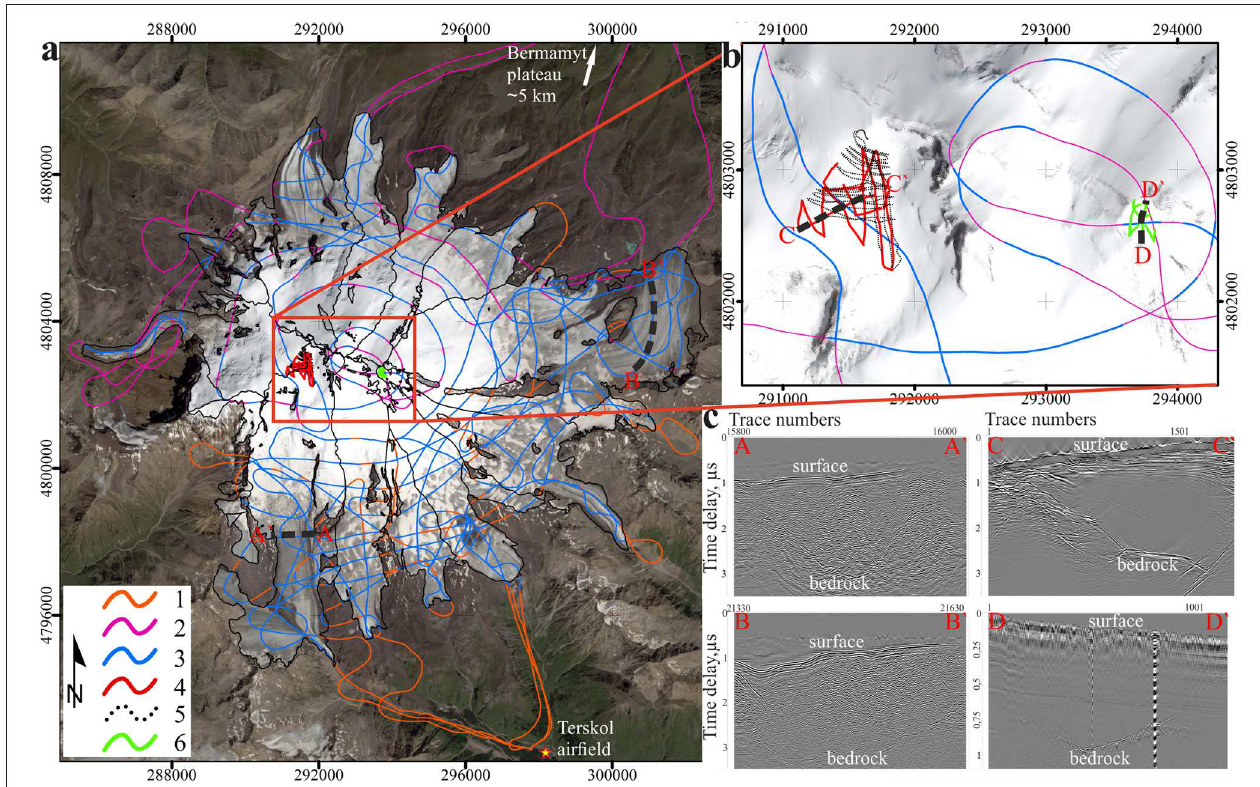
FIGURE 2 | (a) Ice thickness measurements of Elbrus glaciers in 2013 (1) and 2014 (2). All GPR profiles with detectable bedrock reflections are shown in blue (3). Rectangular coordinates are recalculated for UTM Zone 38 projection. (b) Ground-based measurements carried out in 2017 at the western plateau (4) and eastern crater (5) of Elbrus are shown in the enlarged region. The SPOT 7 image obtained on 20 August 2016 is shown as a background. (c) Typical radargrams from aerial and ground-based radar measurements.